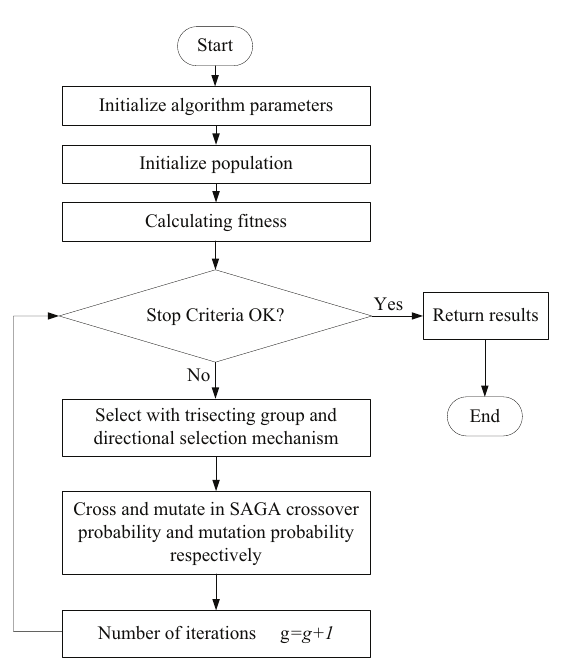
Fig.2. Flow diagram of